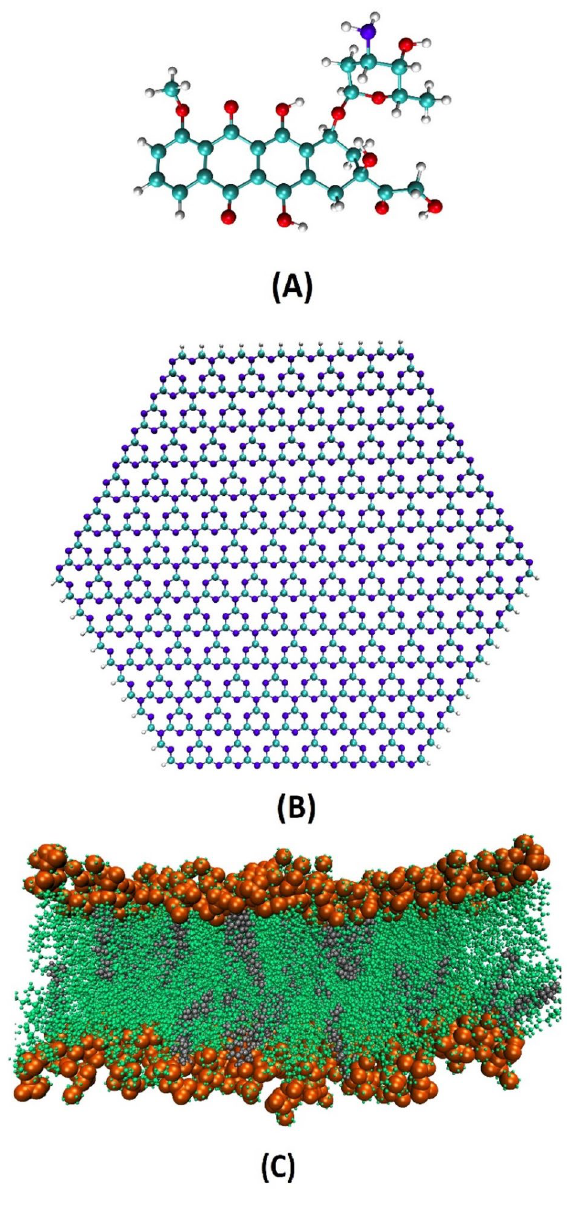
Figure 1. The structure of ( A ) Doxorubicin drug, ( B ) Carbon nitride nanosheet, ( C ) POPC bilayer,